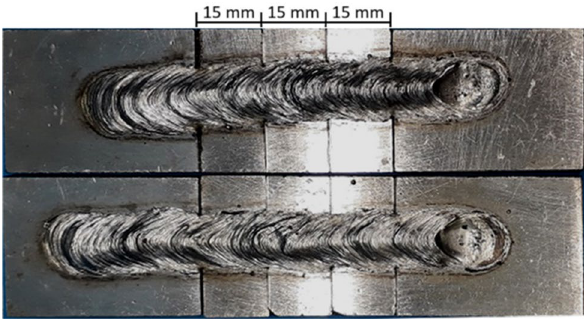
Fig. 3 Wet welded samples based on ISO 3690—sample geometry C